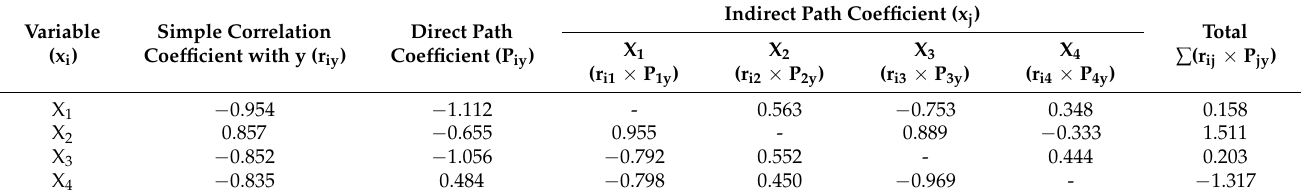
Table 3. Path analysis of cellulase activity (y) in giant panda intestine and relative abundance (Xi) of intestinal dominant flora. Variable Simple Correlation (x i ) Coefficient with y (r iy